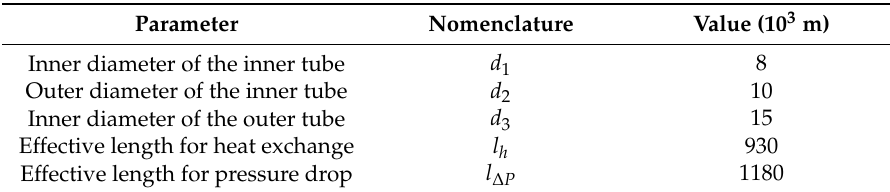
Table 2. Dimensions of the tube-in-tube heat